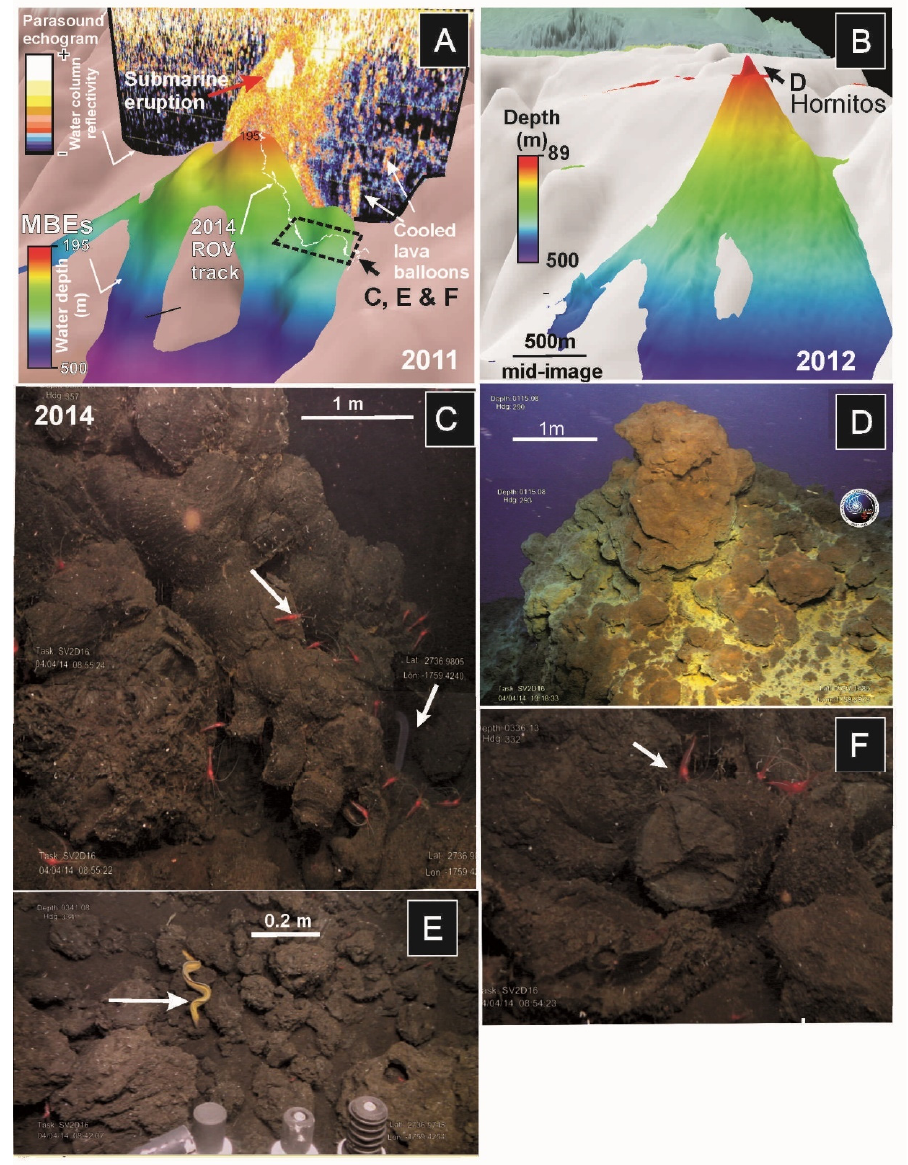
Figure 9. Sequence of MBES during and after El Hierro submarine eruption superimposed on previous bathymetry (in white colour): ( A ) Bathymetry from November 2011 during the eruption when the summit was located at 220 mbsl. Overlay on the bathymetry, a 2D image of parasound echosounder showing the volcanic eruption rising throughout the water column; ( B ) Bathymetry after the eruption in June 2012 (summit located at 89 mbsl). ROV images taken in April 2014 showing distinct habitats developed after the eruption: ( C ) Pillow-lavas flowing downslope with abundant shrimps (mainly Plesionika ), serpulid worms and small oysters ( Neopycnodonte cochlear , some of the small white dots on the rocks); ( D ) Hornitos (hydrothermal vents) developed at the summit of the volcano draped by yellow and orange iron-sulfide bacterial mats; ( E ) Lava balloons along the slope of the recent volcano showing demersal fauna such as moray eels ( Gymnothorax ); and ( F ) Accumulations of lava bombs colonized by shrimps ( Plesionika ).